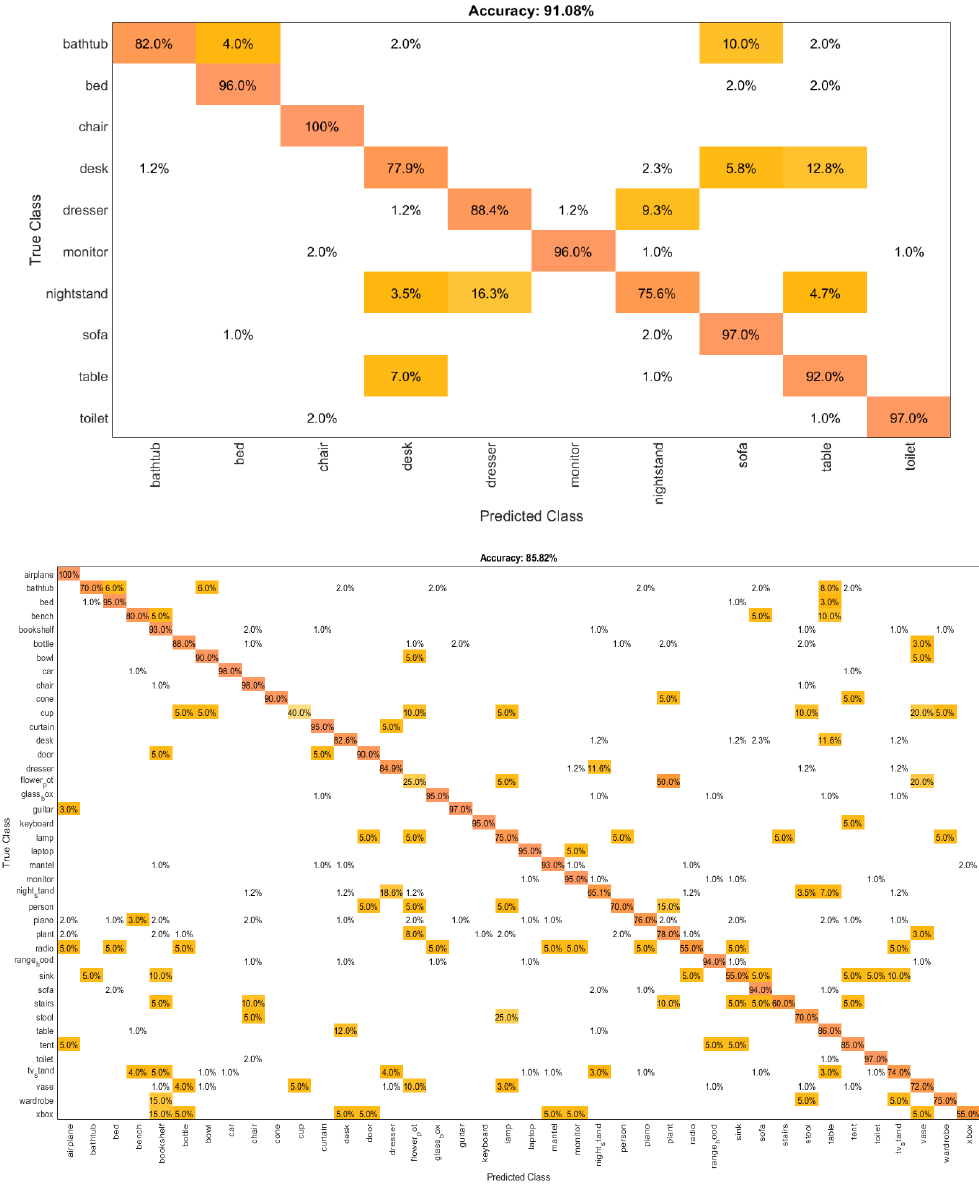
Figure 9. The confusion matrix for datasets: Modelnet10 ( top ) and ModelNet40 ( bottom ).